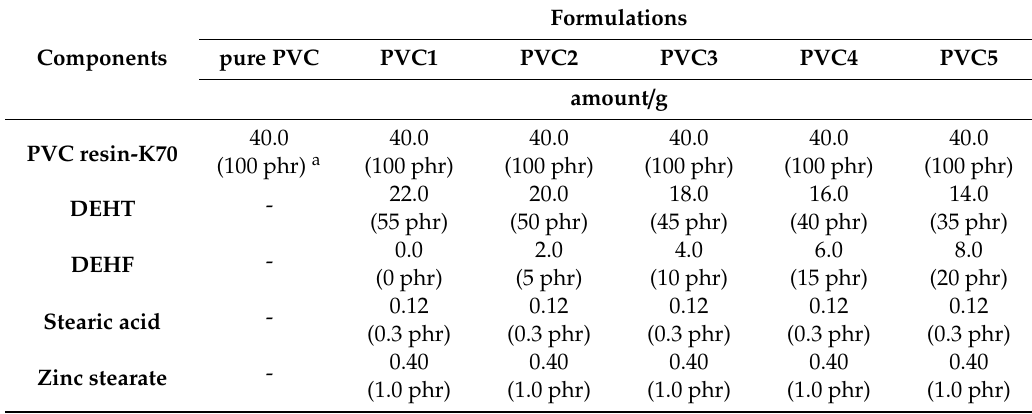
Table 1. Compositions of the di ff erent formulations of PVC-DEHF / DEHT prepared.